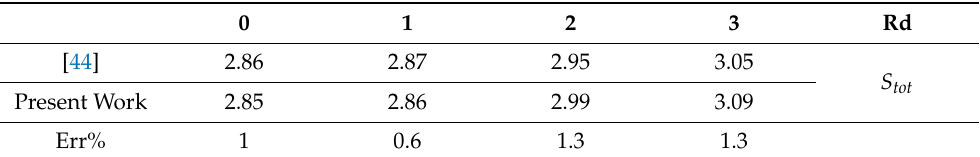
Table 3. Comparing the EGE of the present study and at different RAP values, with Ra = 10 5 , ϕ = 0.03, and Ha = 20.